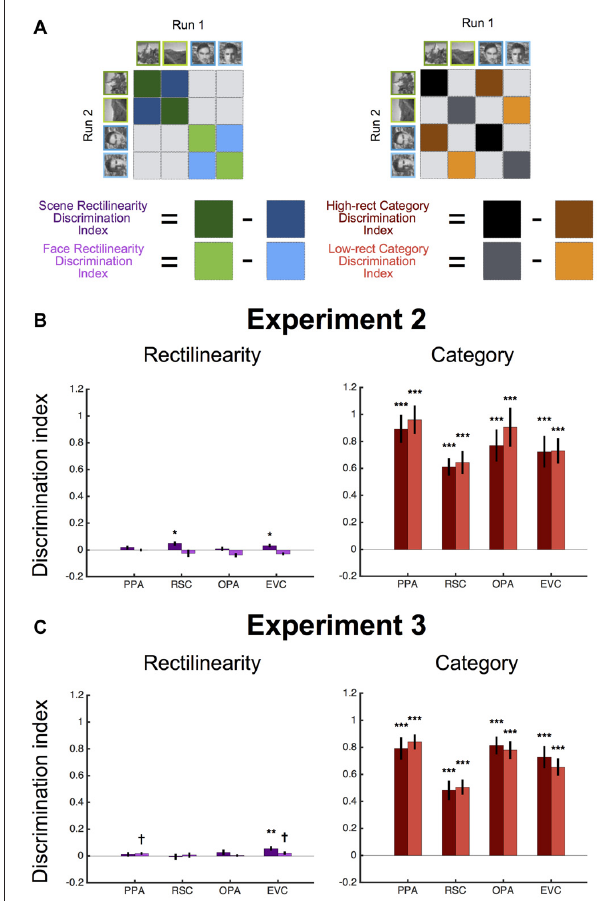
FIGURE 4 | Multivariate results for Experiments 2 and 3. (A) To test for information about rectilinearity in each ROI, we computed a discrimination index that was the difference in split-half pattern similarity (r) between the same rectilinearity conditions and different rectilinearity conditions, separately for scenes and faces. To test for information about stimulus category, we computed a discrimination index that was the difference in split-half pattern similarity between the same category conditions and different category conditions, separately for high- and low-rectilinearity stimuli. (B) Experiment 2 average discrimination indices ( ± 1 SEM) for rectilinearity and category in each ROI. There was no information about rectilinearity independent of category in any ROI, although all ROIs exhibited significant information about stimulus category. (C) Experiment 3 average discrimination indices ( ± 1 SEM) for rectilinearity and category in each ROI. There was significant information about rectilinearity in early visual cortex (EVC), but not in other ROIs. All ROIs exhibited significant information about stimulus category. ( † p < 0.08; ∗ p < 0.05; ∗∗ p < 0.01; ∗∗∗ p <